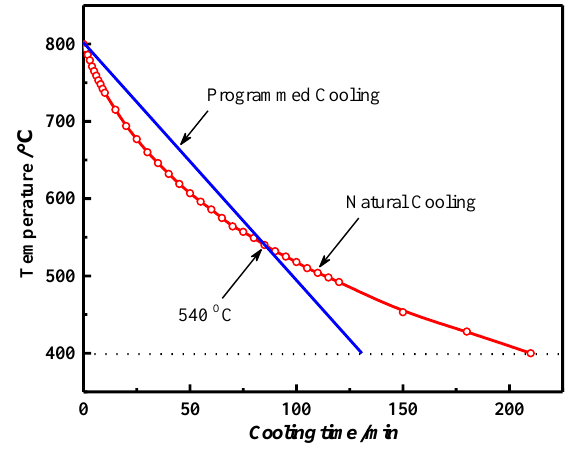
Figure 9. Cooling curves of programmed cooling and natural cooling.